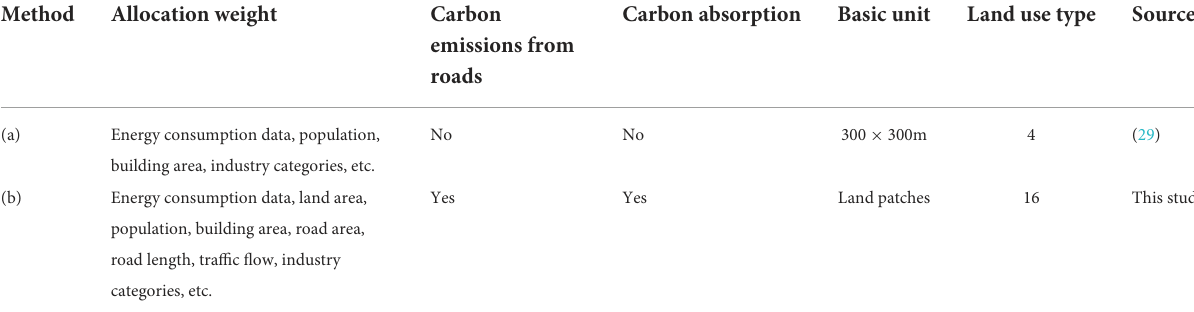
TABLE 7 Detailed differences of the two carbon emissions mapping